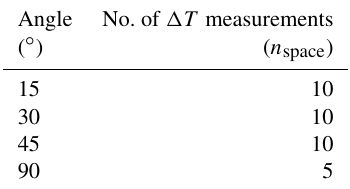
Table D2. Temperature differences for each setup ( n space ).